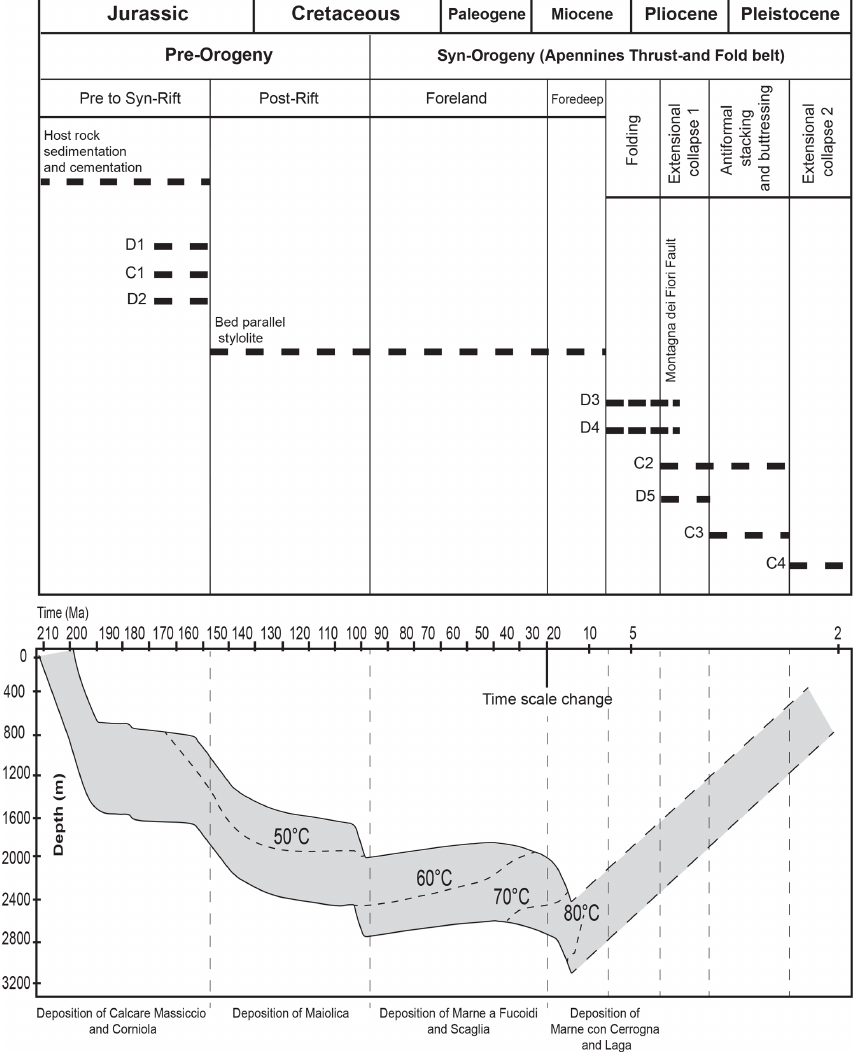
Figure 14. Generalized paragenesis of diagenetic phases in relation to deformational stages and burial history of the Calcare Massiccio Formation in the Montagna dei Fiori Anticline. The deformational stages are from Storti et al. (2018) and the burial curve is based on Ronchi et al. (2003). The burial curve was made based on paleodepth, paleotemperatures, sedimentation rate, and paleoheat